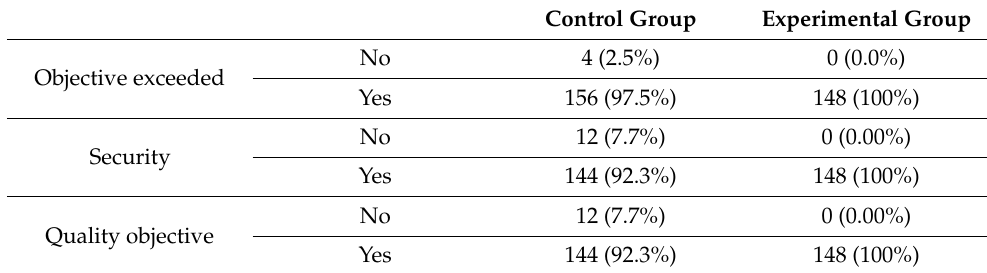
Table 4. Results for the descriptive analysis of the variables analysed on AED. Control Group Experimental Group